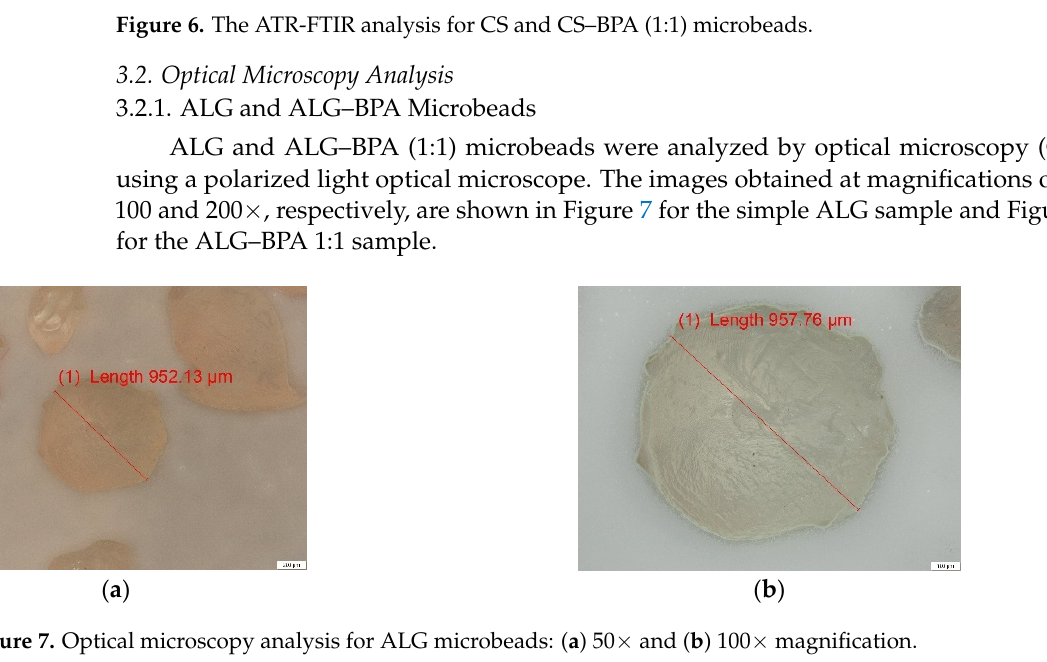
( b ) Figure 7. Optical microscopy analysis for ALG microbeads: ( a ) 50× and ( b ) 100× magnification.